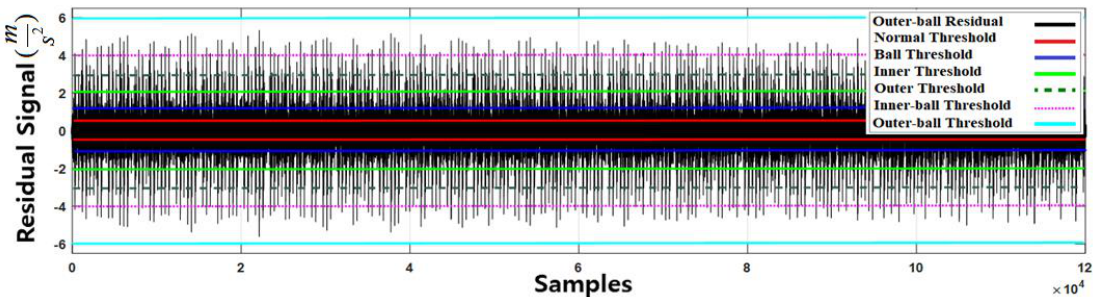
Figure 16. Residual signal for the inner-ball faulty condition, normal, ball, inner, outer, and inner-ball thresholds with a crack width of 6 mm.